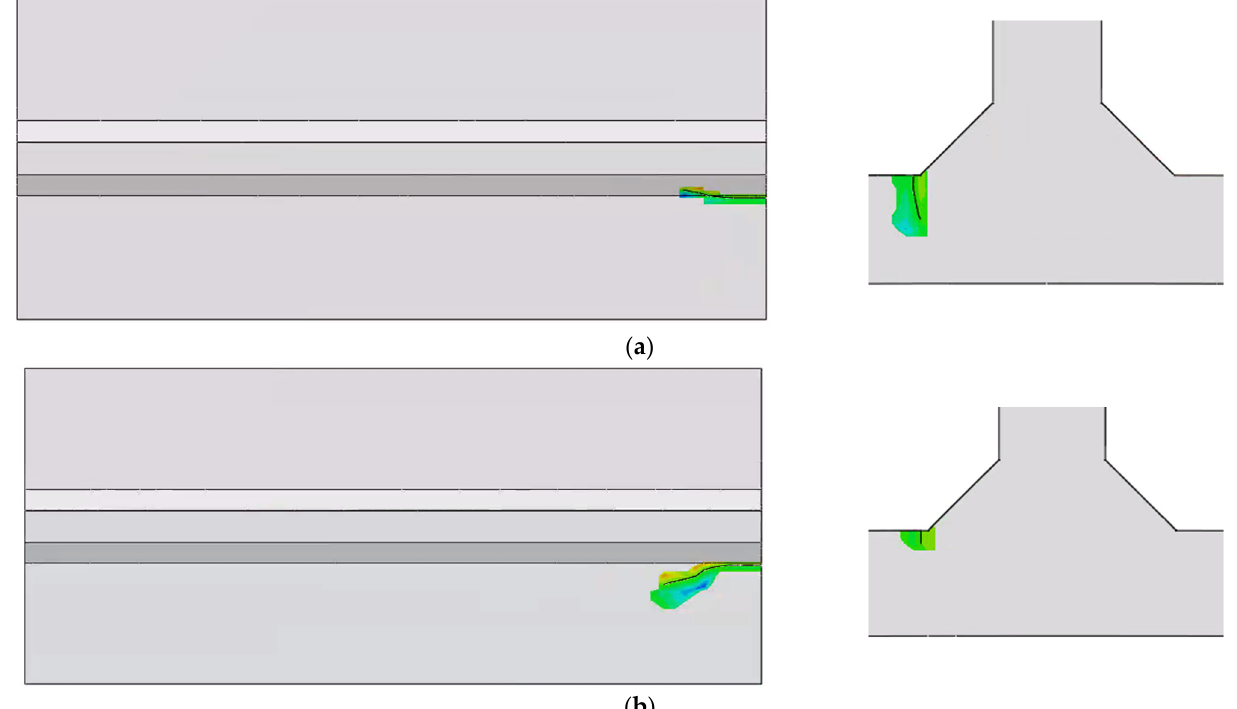
Figure 24. Crack propagation under a maximum displacement load of 0.35 mm when the initial crack is located in the end of the weld: ( a ) without a residual stress field at 100,000 cycles; ( b ) with residual stress field at 100,000 cycles.